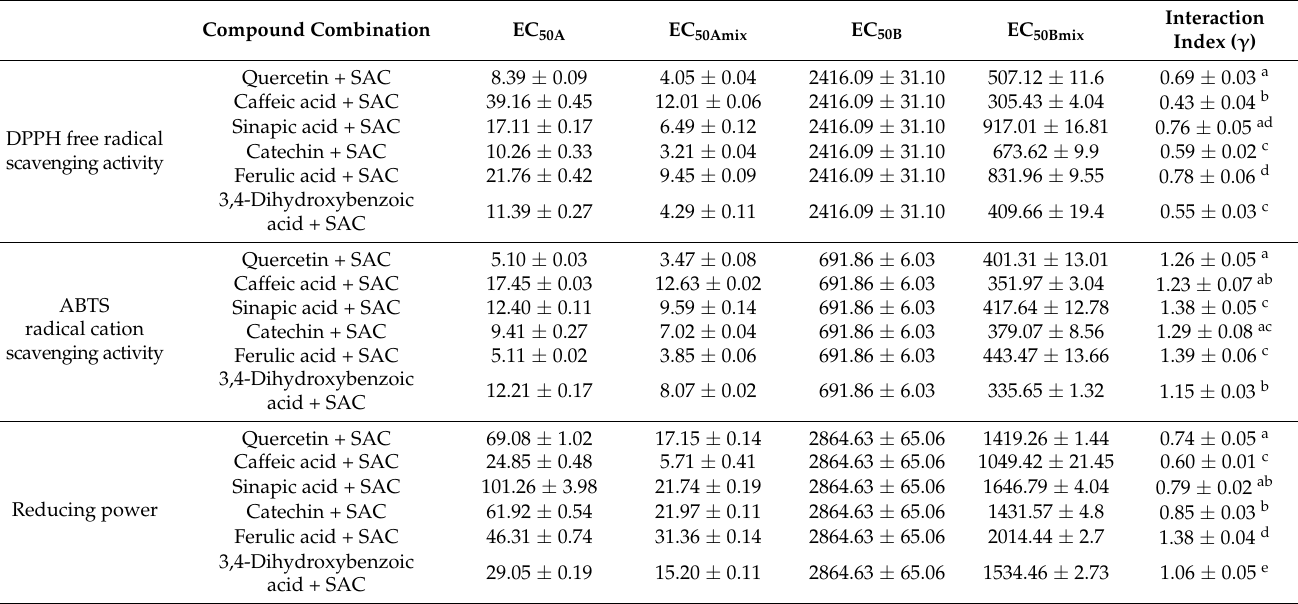
Table 2. Interaction index values for the combination of the different compounds determined by DPPH, ABTS, and reducing